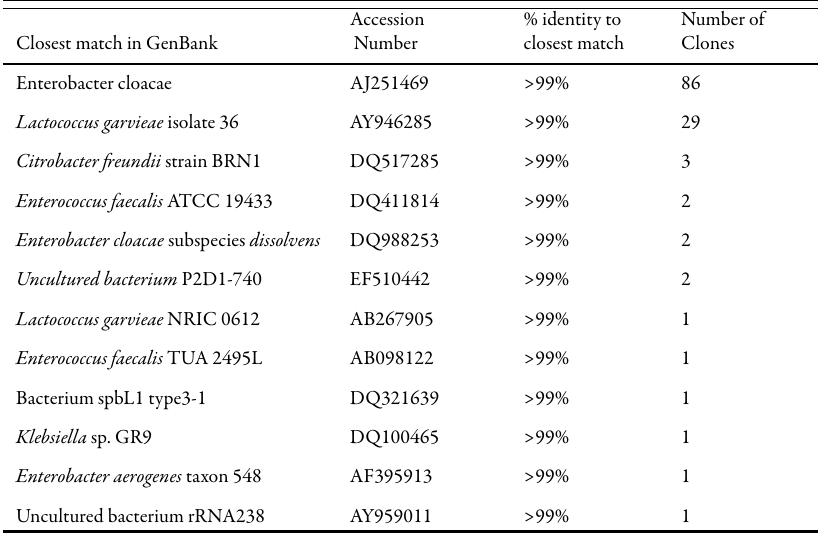
table 1. NcBI BLAst results for the 16s rrNA gene from 130 clones from the colony collected from the lab-reared Bogalusa colony.